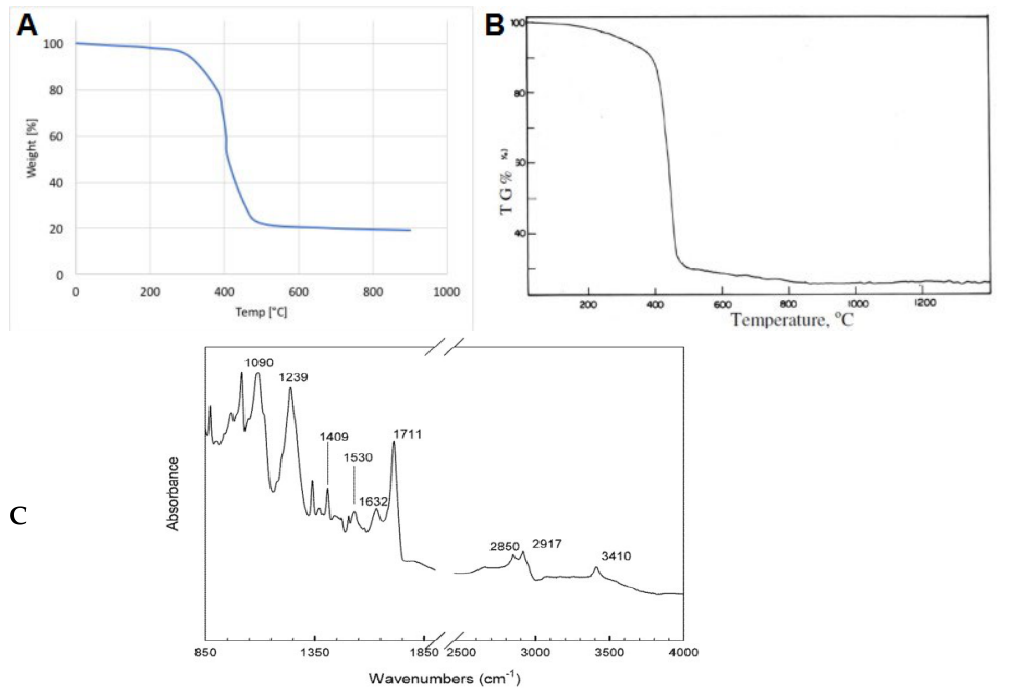
Figure 19. ( A ) TGA of textile materials and ( B ) of Nylon 6.6 [10], as well as ( C ) the FTIR spectrum of WTTF [43].